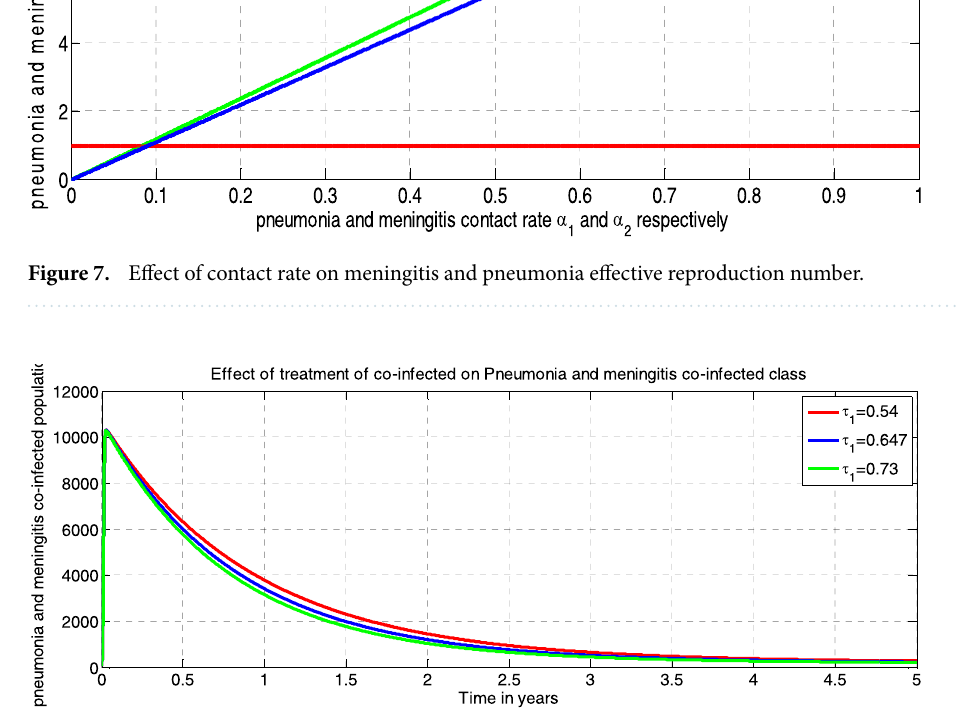
Figure 8. Effect of treatment of co-infected class on meningitis and pneumonia co-infected